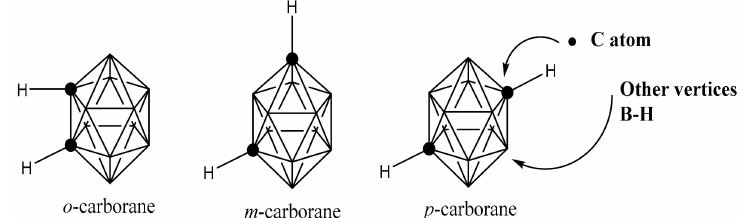
Figure 1. Structure of carborane due to the attachment of carbon at di ff erent